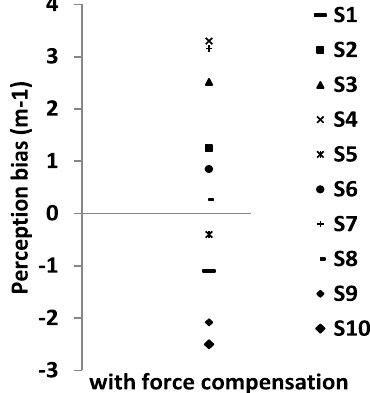
Fig. 13. Results of Exp. 4. Individual biases under the condition with